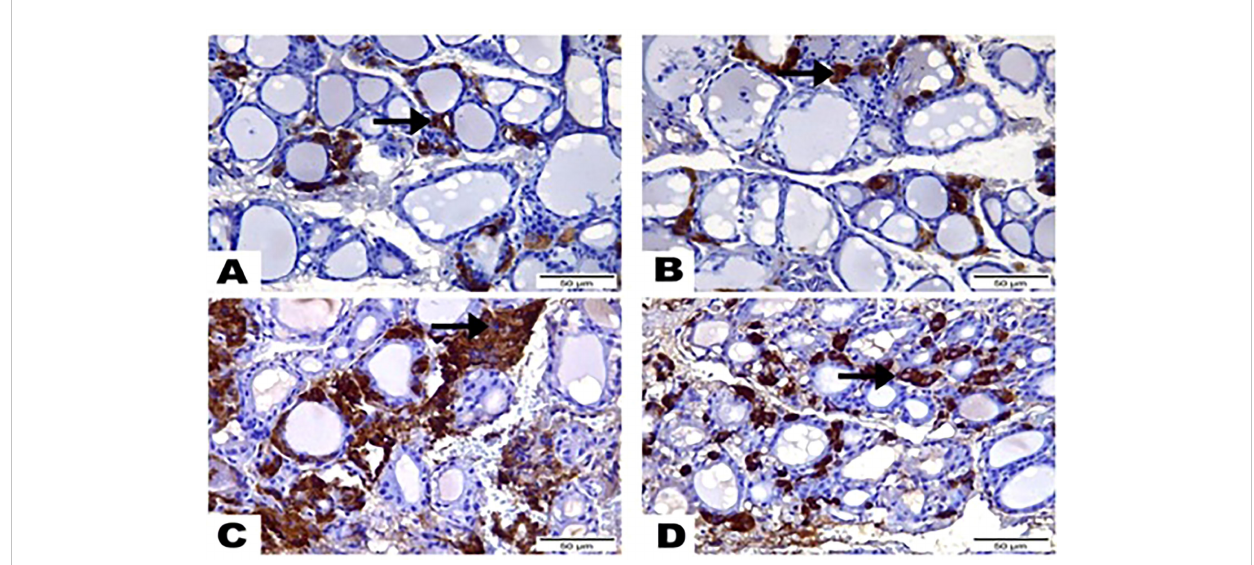
FIGURE 4 Photomicrographs displayed the expression of Calcitonin-Antibody, (A) in the thyroid gland section of (G1) expressed in a few amounts to Calcitonin Antibody (arrow), while greatest most para-follicular cells identi fi ed as blue negative nucleus. (B) Thyroid gland section of (G2) marked also little reactivity to Calcitonin Antibody (arrow) although greatest most para-follicular cells recognized as blue negative nucleus. (C) Thyroid gland section of (G3) highlighted a strong brown positive reactivity to Calcitonin-Antibody (arrow). (D) Thyroid gland section of (G4) signi fi ed mild reactivity with brown positive expression to Calcitonin-Antibody (arrow). (Hematoxylin & Eosin Stain, Magni fi cation Power= x400 & Scale Bar= 50 m